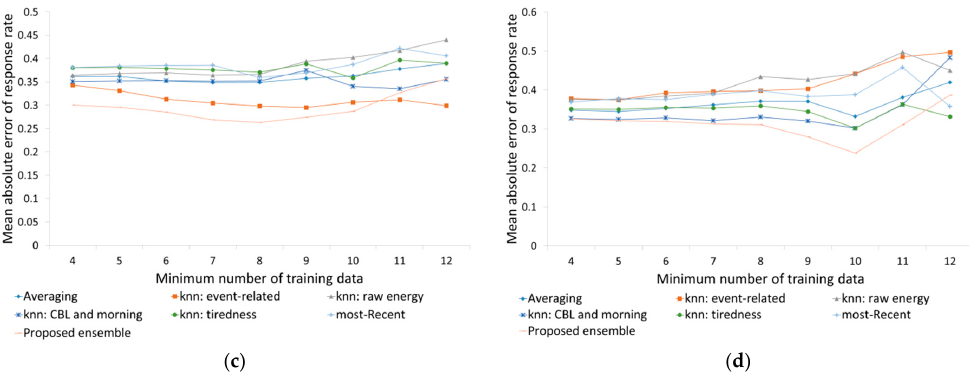
Figure 6. Prediction error comparison. ( a ) Customer set A (From service provider A); ( b ) Customer set B (From service provider B); ( c ) Customer set A (Outliers eliminated); ( d ) Customer set B (Outliers eliminated).